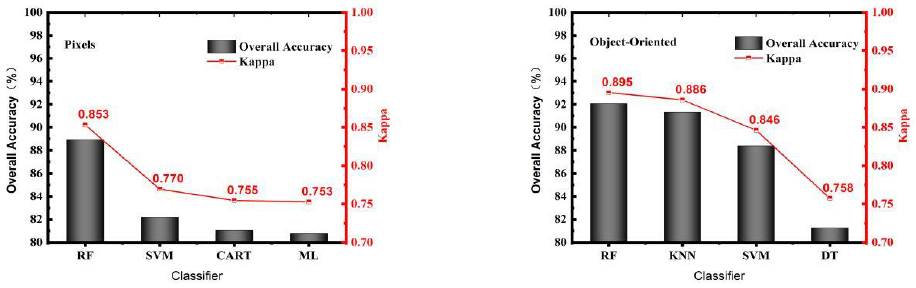
Figure 10. The overall accuracy and kappa coefficient of crops based on different classification meth- ods.